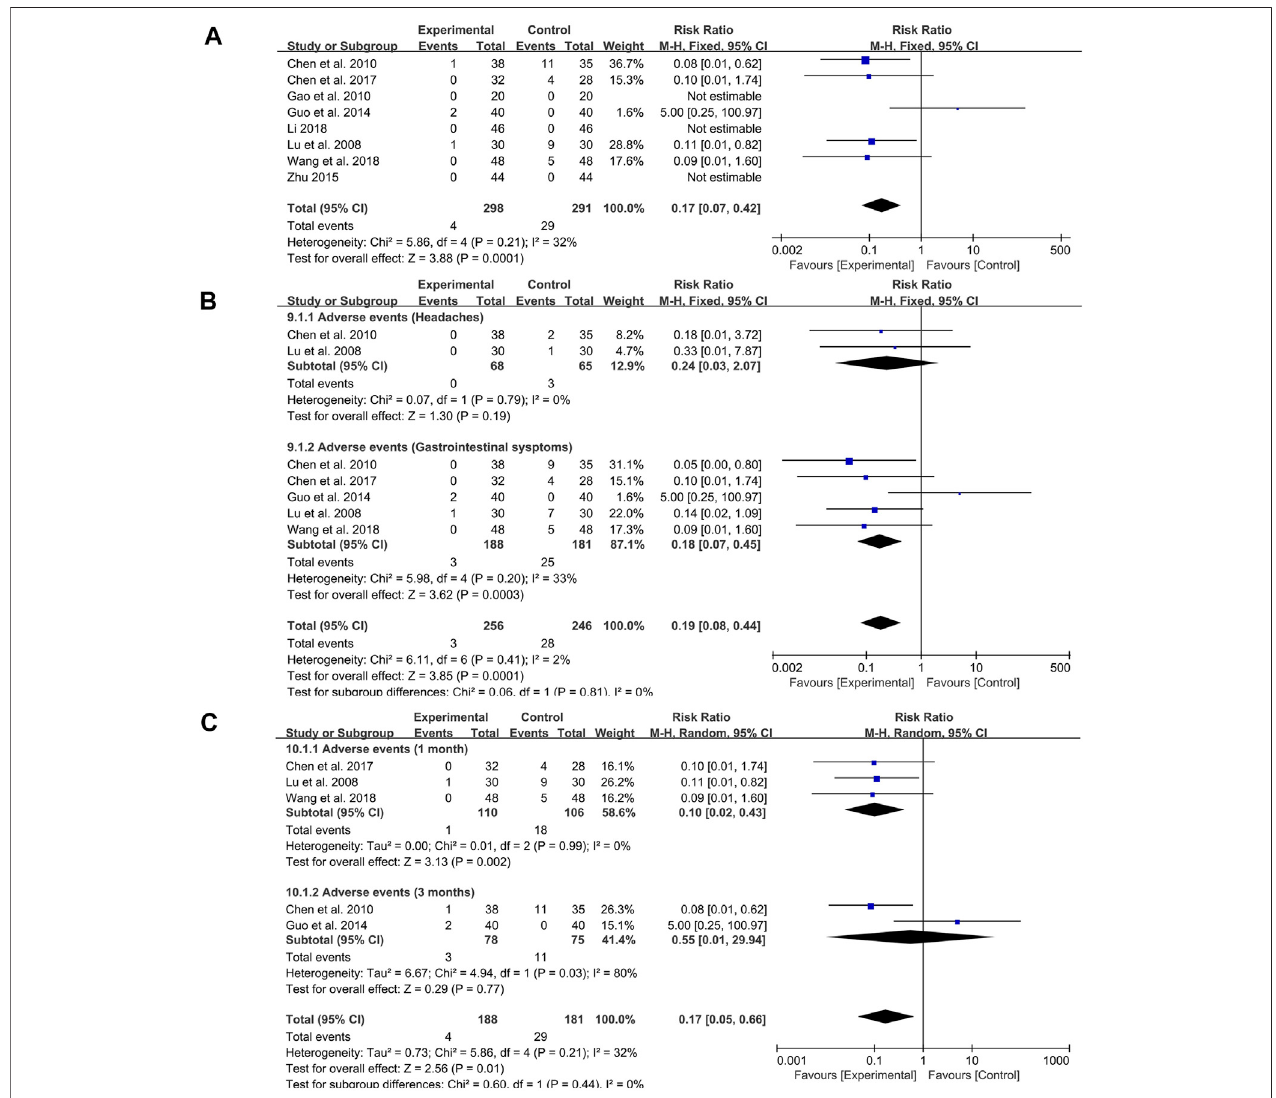
FIGURE 8 | Forest plot displaying the results of the meta-analysis for adverse events. (A) The total incidence of adverse events. (B) The incidence of speci fi c symptoms of adverse events. (C) The incidence of adverse events with different course of treatment.